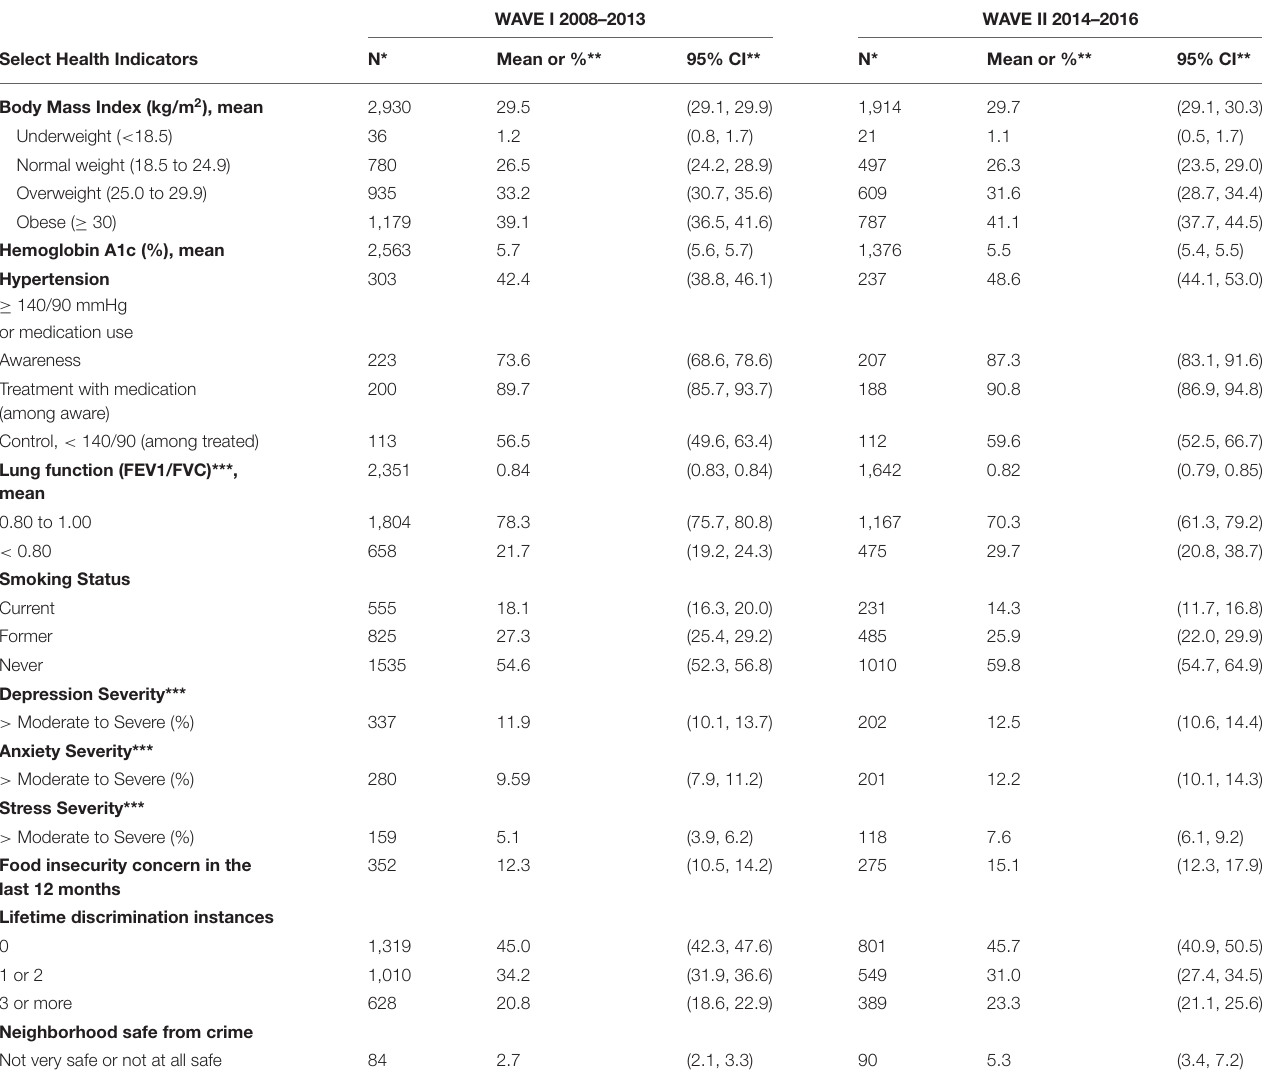
TABLE 4A | Select health indicators for SHOW adults WAVES I and II, weighted for statewide sample